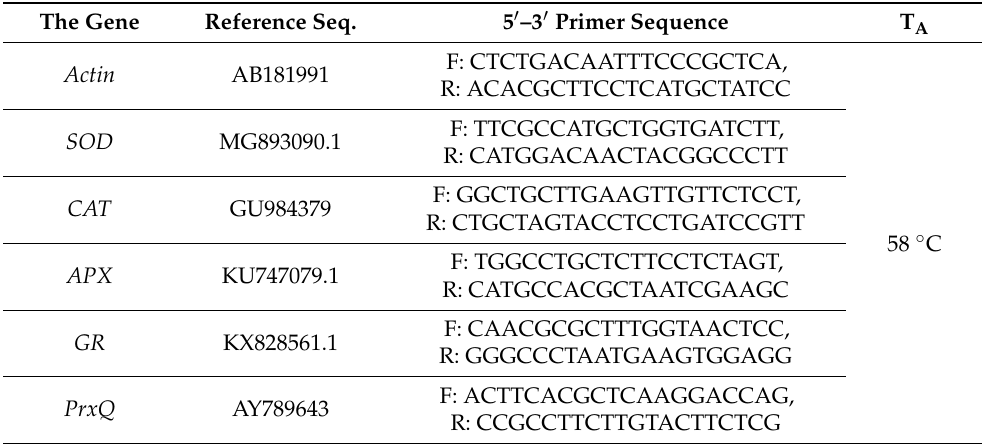
Table 4. Primers sequences for RT-qPCR of stress-related genes in Zea mays. The Gene